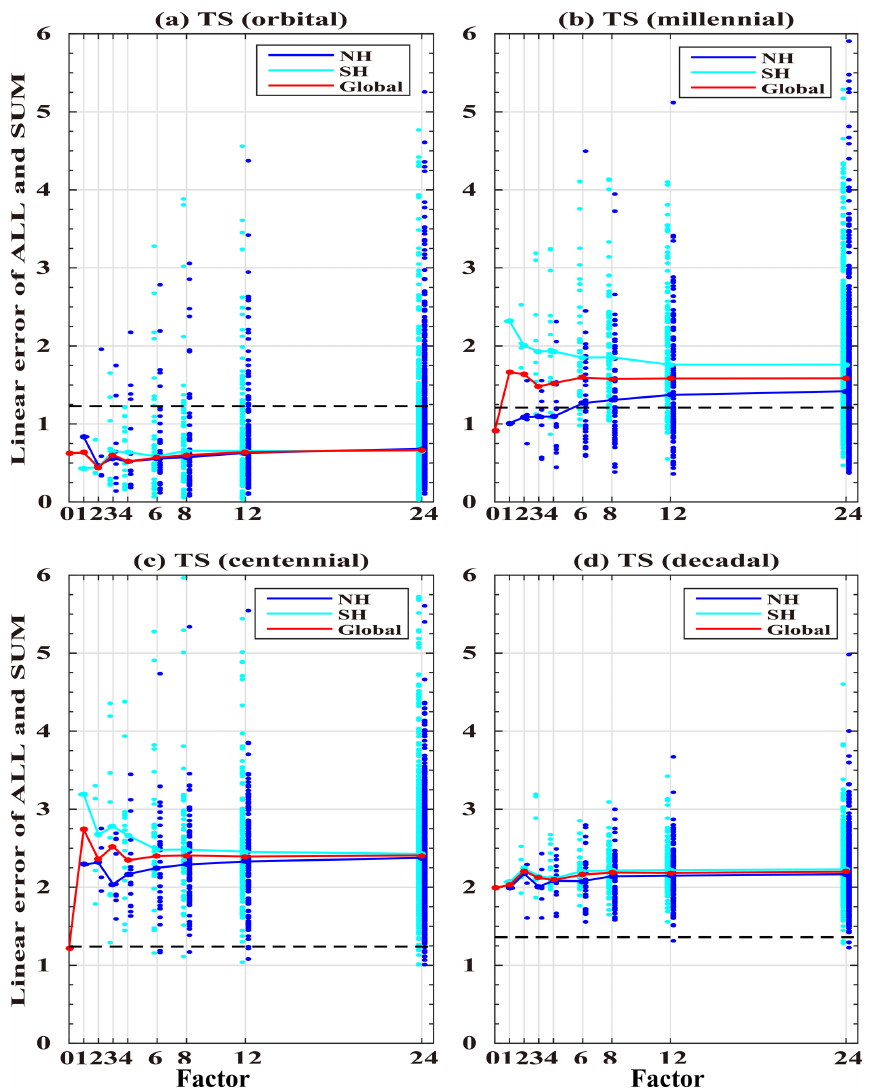
Figure 4. Same as Fig. 3 but for linear error ( L e , y axis). The black thick dashed line is 95% confidence level of L e . There are only about 10 points with the L e larger than 6, so they are ignored in (a–c)